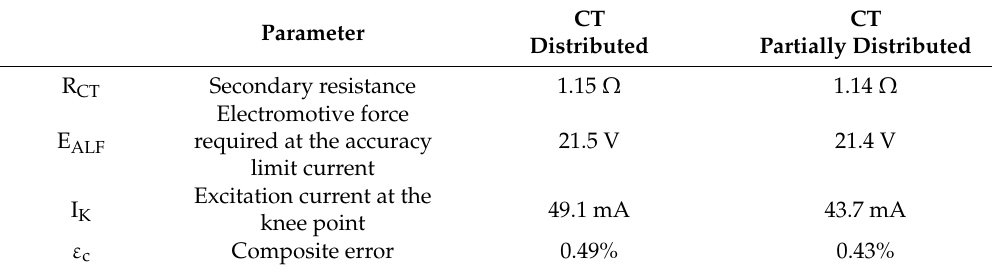
Table 2. Current transformers indirect method test